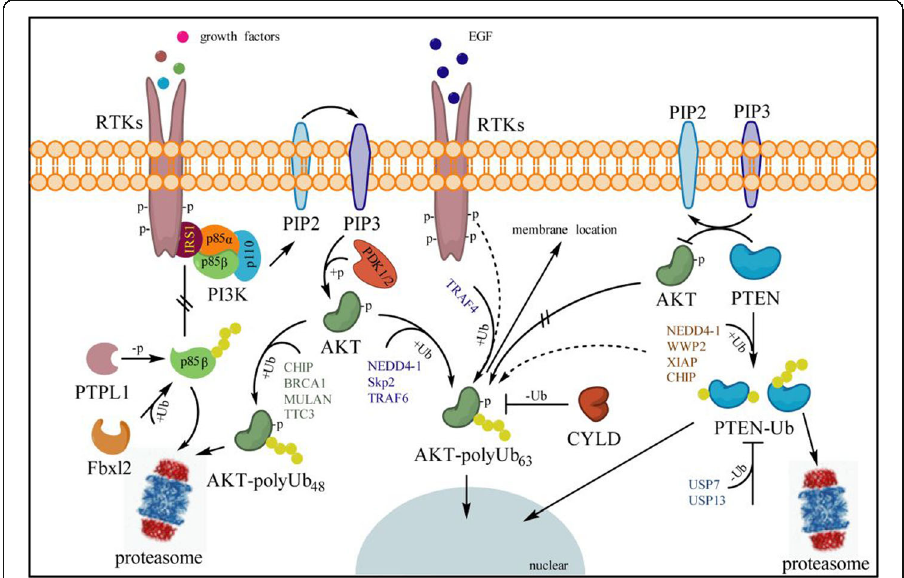
Fig. 2 Ubiquitination on PI3K-AKT signal . Under the conditions of growth factor stimuli, such as insulin, activated RTKs recruit IRS1 (insulin receptor substrate 1) for binding and activation of p85-p110 heterodimers (PI3K). With the assistance of phosphatase PTPL1, free p85 β is ubiquitinated by Fbxl2 and degraded through the proteasome system to block its competition with p85-p110 heterodimers binding to IRS1, thereby promoting activation of the PI3K-AKT signal. The p110 subunit of PI3K catalyzes the conversion of PIP2 to PIP3, which recruits AKT to the plasma membrane for activation through PDK1 and PDK2. In that process, activation of AKT is inhibited by PTEN through conversion of PIP3 to PIP2 to restraint the downstream events, i.e., K48-linked polyubiquitination on phosphorylated AKT is triggered by E3 ligases CHIP, BRCA1, MULAN or TTC3 for proteasome degradation, but K63-linked AKT is induced by NEDD4 – 1, Skp2 and TRAF6 to mediate its nuclear localization for further activation of the PI3K-AKT signal. However, TRAF4 is the main effector for AKT K63-linked ubiquitination and promotes EGF-induced AKT membrane recruitment in human lung cancer cells to induce tumorigenic properties. Deubiquitinating enzyme CYLD plays a tumor suppressor role in inhibiting AKT activity by removing AKT K63-linked ubiquitin chains and serves as a negative regulator for AKT-mediated tumorigenesis. Ubiquitinated PTEN with poly-ub chains is usually degraded by the proteasome system, while partial mono-ubiquitinated forms translocate into the nucleus to escape proteasome degradation, mediated by NEDD4 – 1, WWP2, XIAP and CHIP E3 ligase. However, this progress can be reversed by deubiquitinating enzymes USP7 and USP13 to deactivate the PI3K-AKT